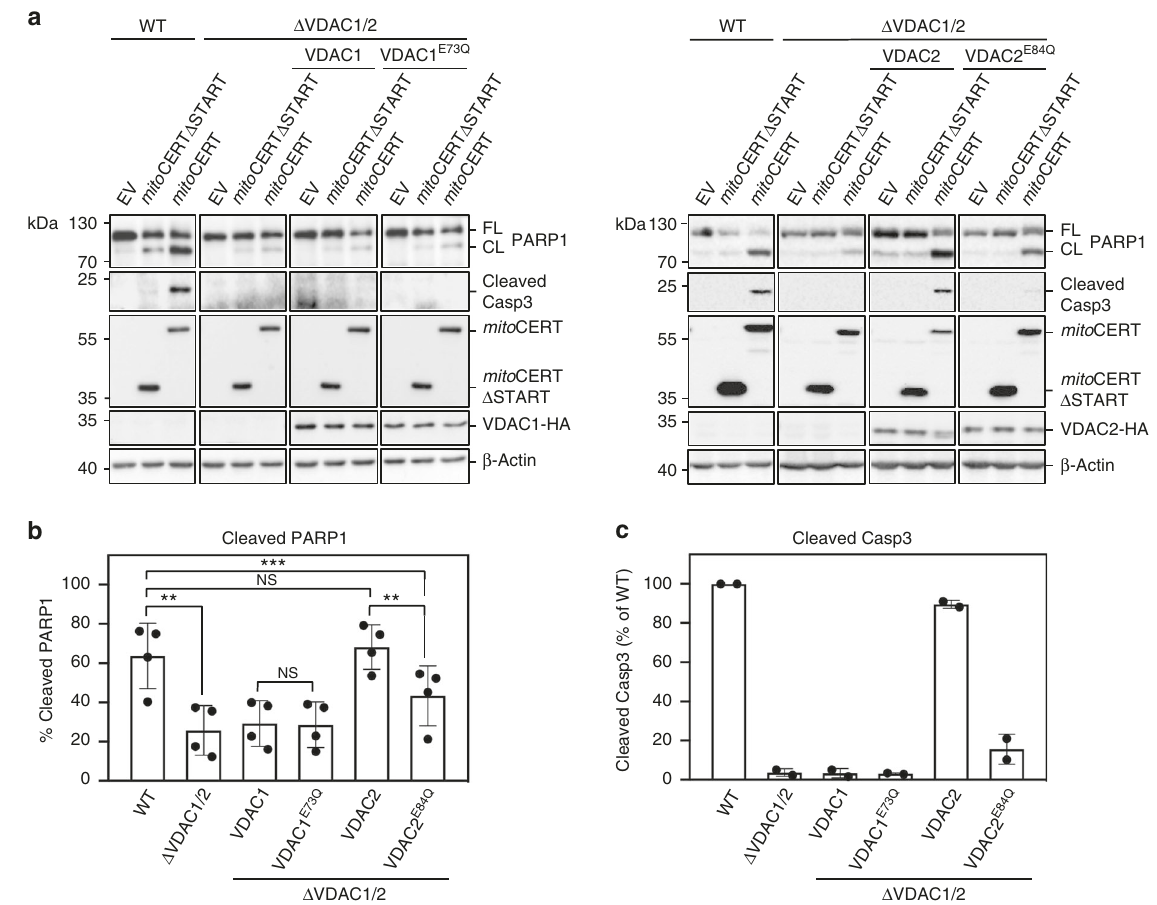
Fig. 7 Ceramide-induced apoptosis critically relies on Glu84 in VDAC2. a WT and Δ VDAC1/2 HCT116 cells stably transduced with HA-tagged VDAC1, VDAC1 E73Q , VDAC2, or VDAC2 E84Q were transfected with empty vector (EV), Flag-tagged mitoCERT, or Flag-tagged mitoCERT Δ START. At 24 h post transfection, cells were processed for immunoblotting with antibodies against PARP1, cleaved caspase-3 (Casp3), the Flag-epitope, the HA-epitope, and β - actin. FL full-length, CL cleaved. b Quantitative analysis of PARP1 cleavage in cells treated as in a . Data are means ± s.d.; n = 4; * p < 0.05, ** p < 0.01 and *** p < 0.001 by two-tailed paired t -test. c Quantitative analysis of cleaved Casp3 in cells treated as in a . Data are means ± s.e.; n = 2. Source data